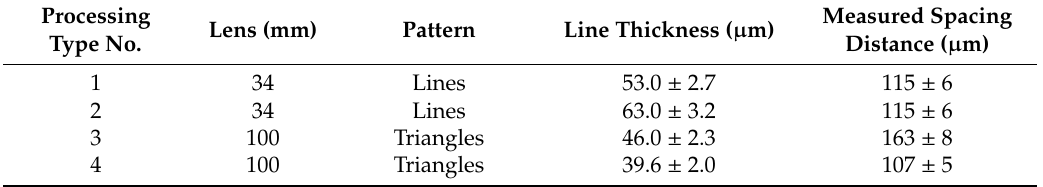
Table 2. Parameters measured from SEM (scanning electron microscopy) images for reference samples. Processing